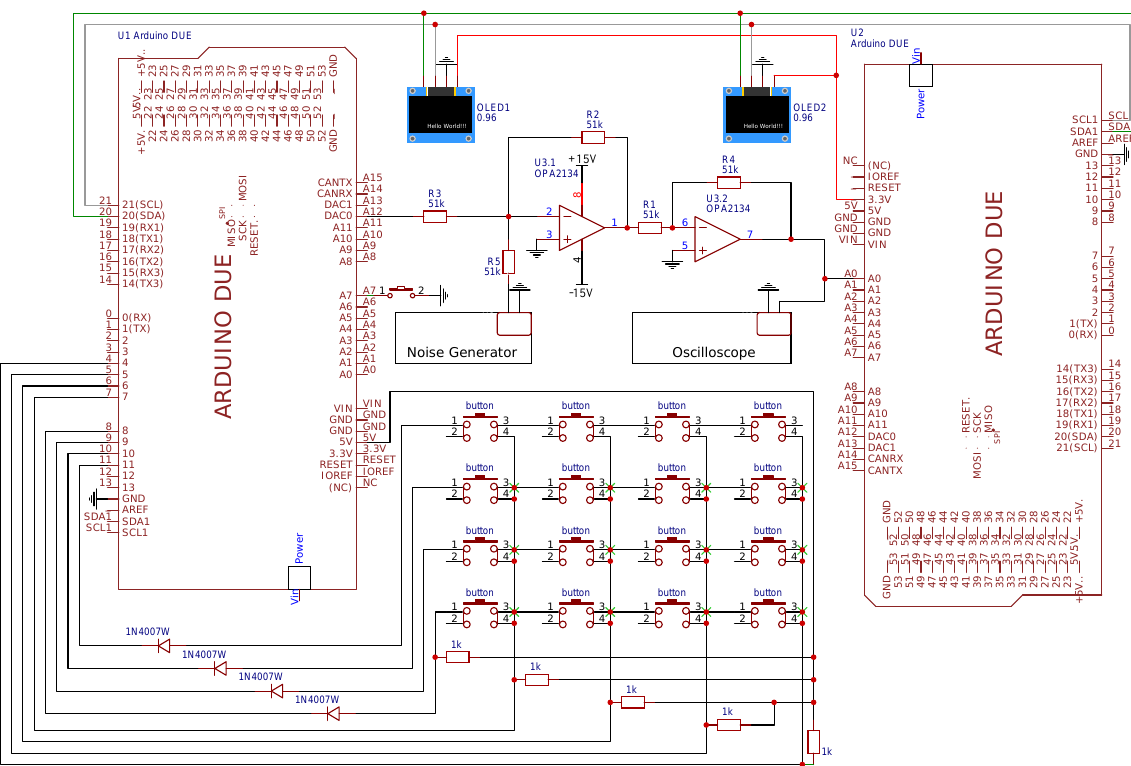
Figure 4. Schematic diagram of chaotic communication